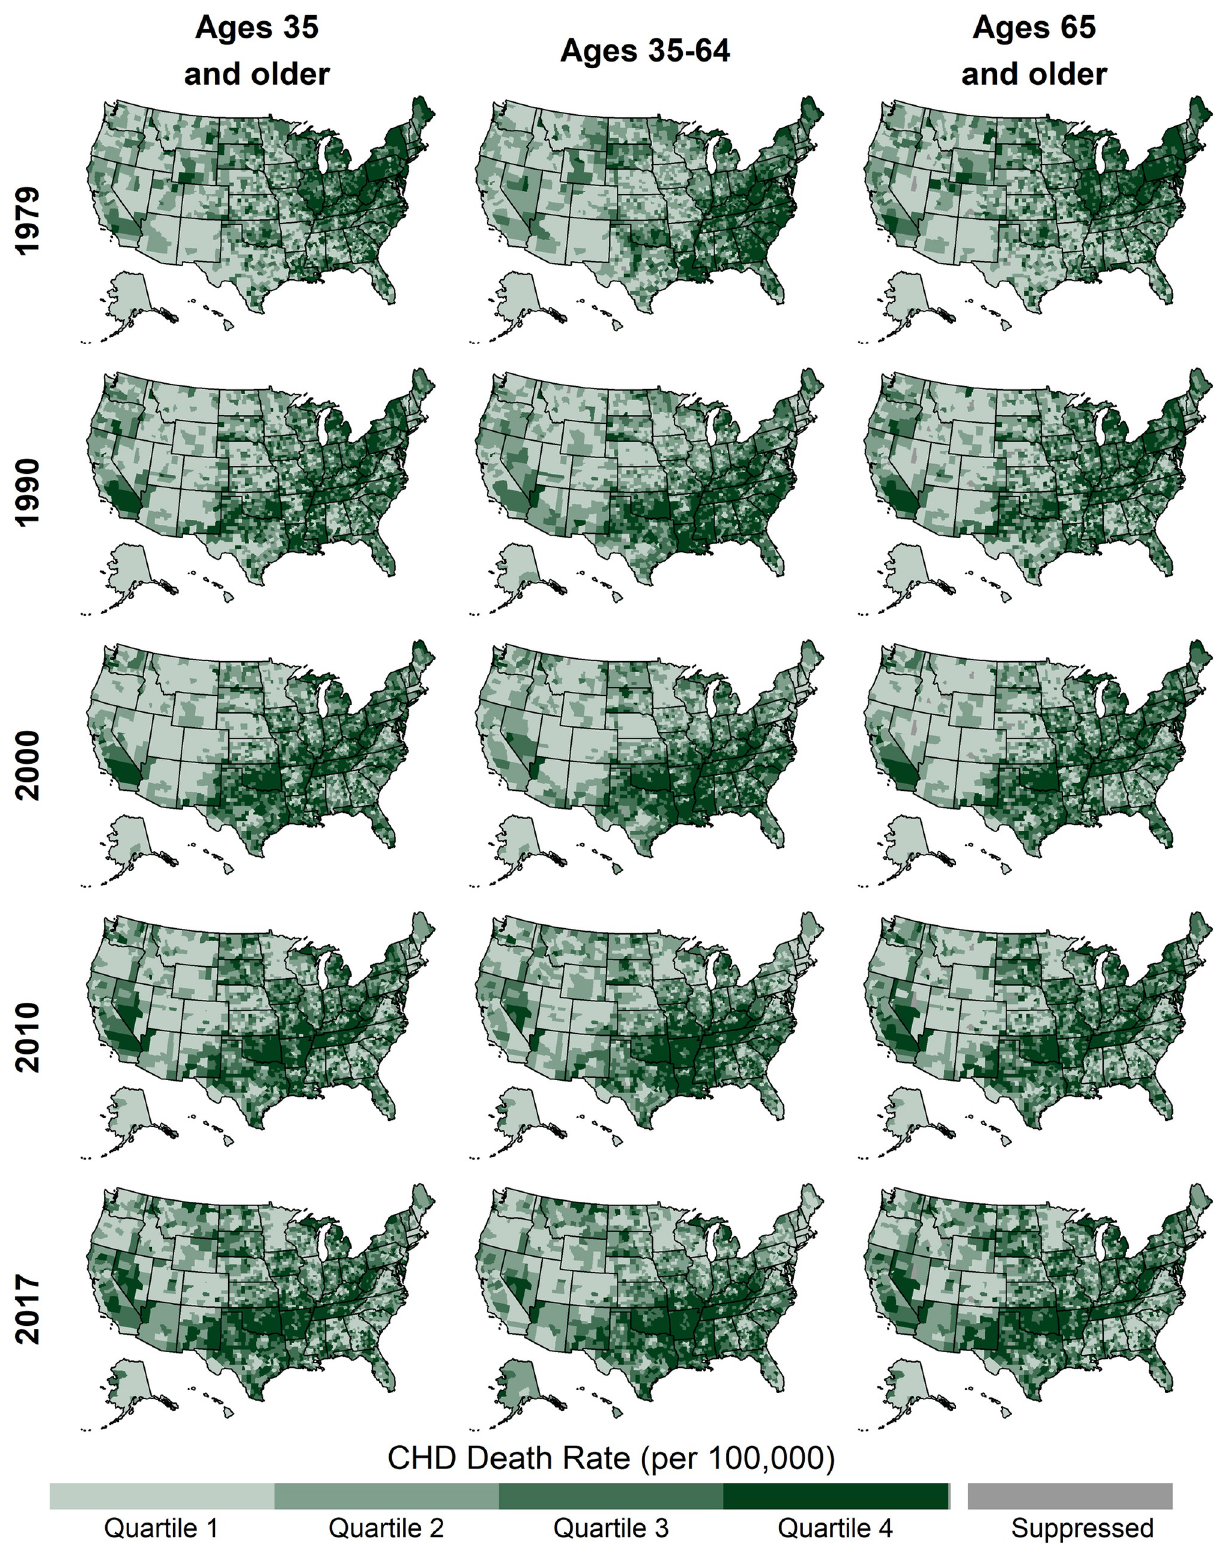
Fig 2. County-level CHD death rates by year and age group, United States, 1979–2017. Quartile ranges for each map are shown in Table 2.